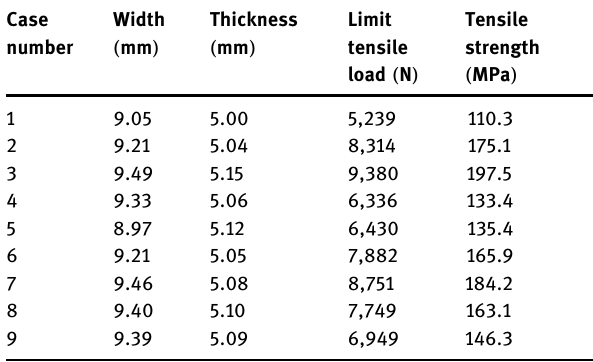
Table 1: The experimental results of the tensile fracture